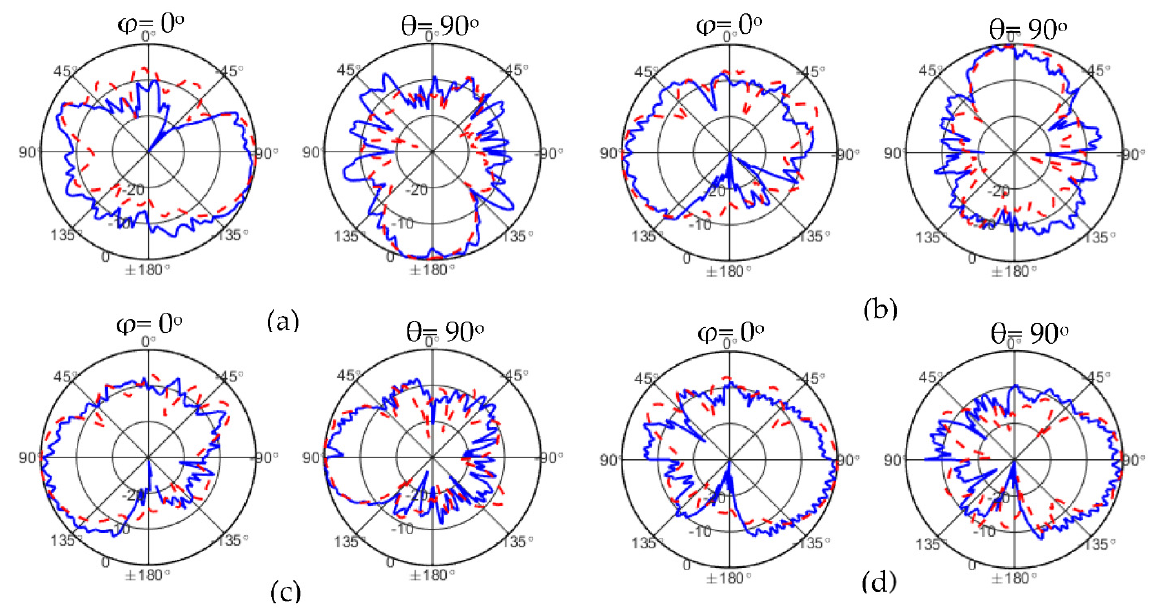
Figure 9. The simulated and measured 2D radiation patterns in terms of gain at 28 GHz: ( a ) Ant. 1, ( b ) Ant. 4, ( c ) Ant. 2, and ( d ) Ant. 3. Simulated: dashed red curves; measured: solid blue curves.